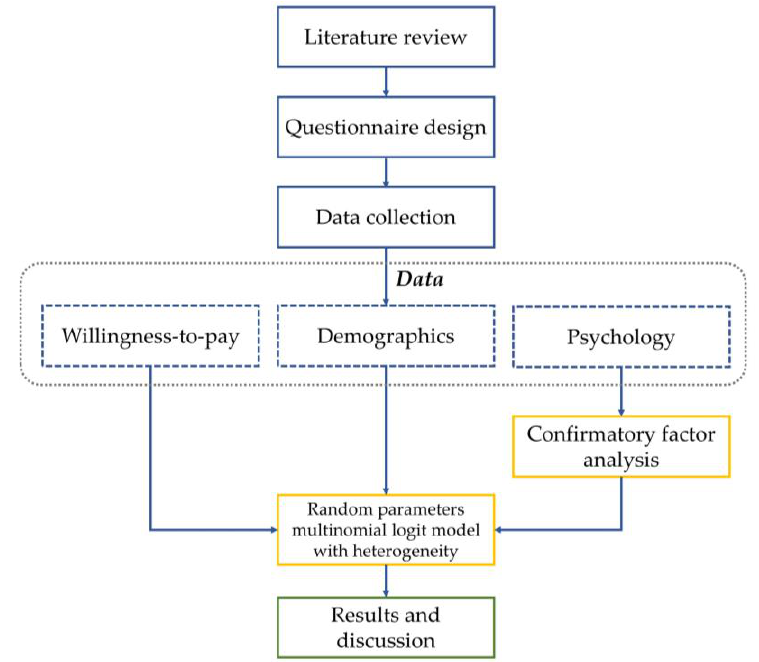
Figure 3. Research procedure.